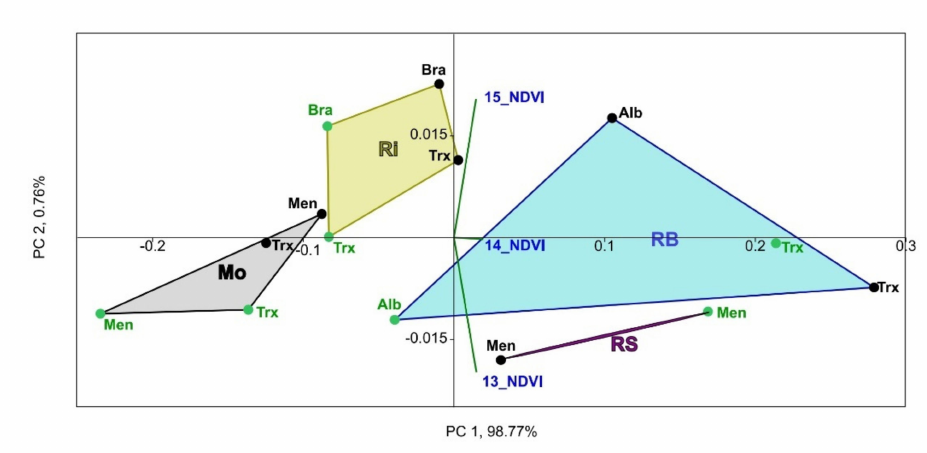
Figure 5. PCA of NDVI during 2013, 2014, and 2015 in vineyards planted with four representative cultivars within four Galician AOPs. AOPs: Mo: Monterrei, Ri: Ribeiro, RS: Ribeira Sacra, RB: R í as Baixas; grape cultivars (in green: organic, in black: conventional): Trx: Treixadura, Alb: Albariño, Bra: Brancellao, Men: Menc í